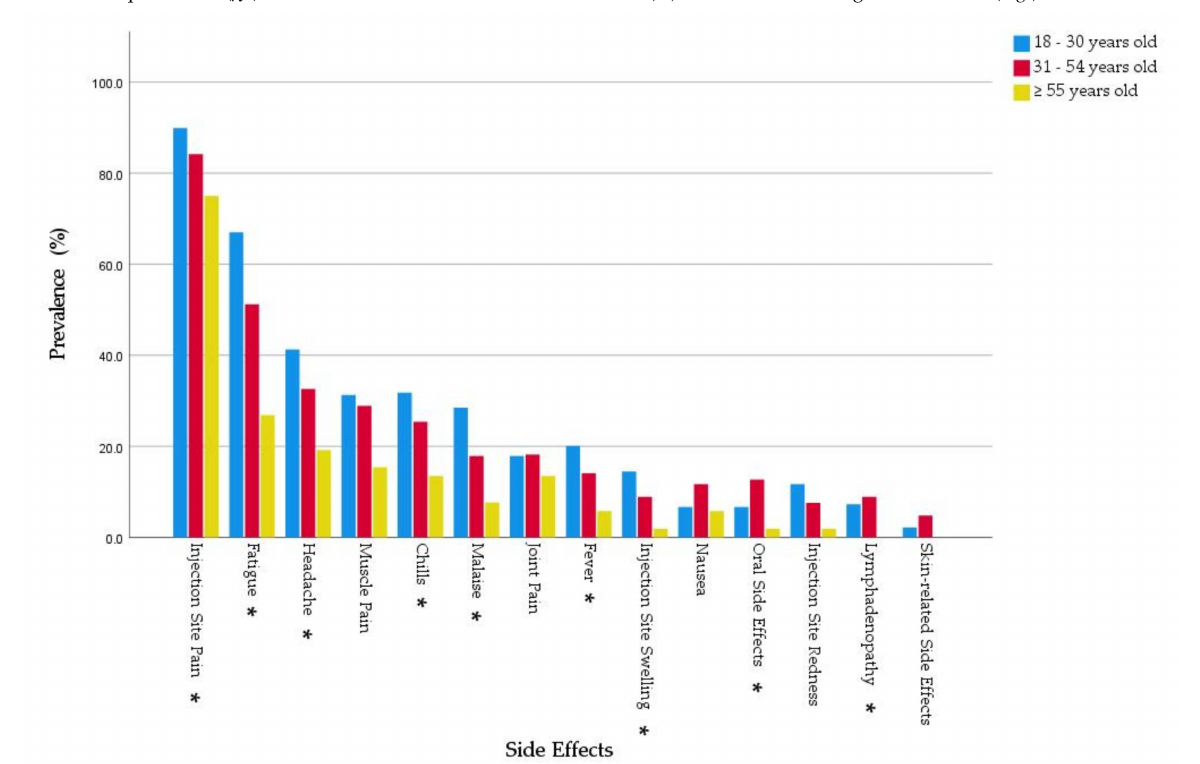
Figure 3. Side effects experienced by Slovak healthcare workers who received BNT162b2 and stratified by age group, February–March 2021 ( n = 522). * Significance level <